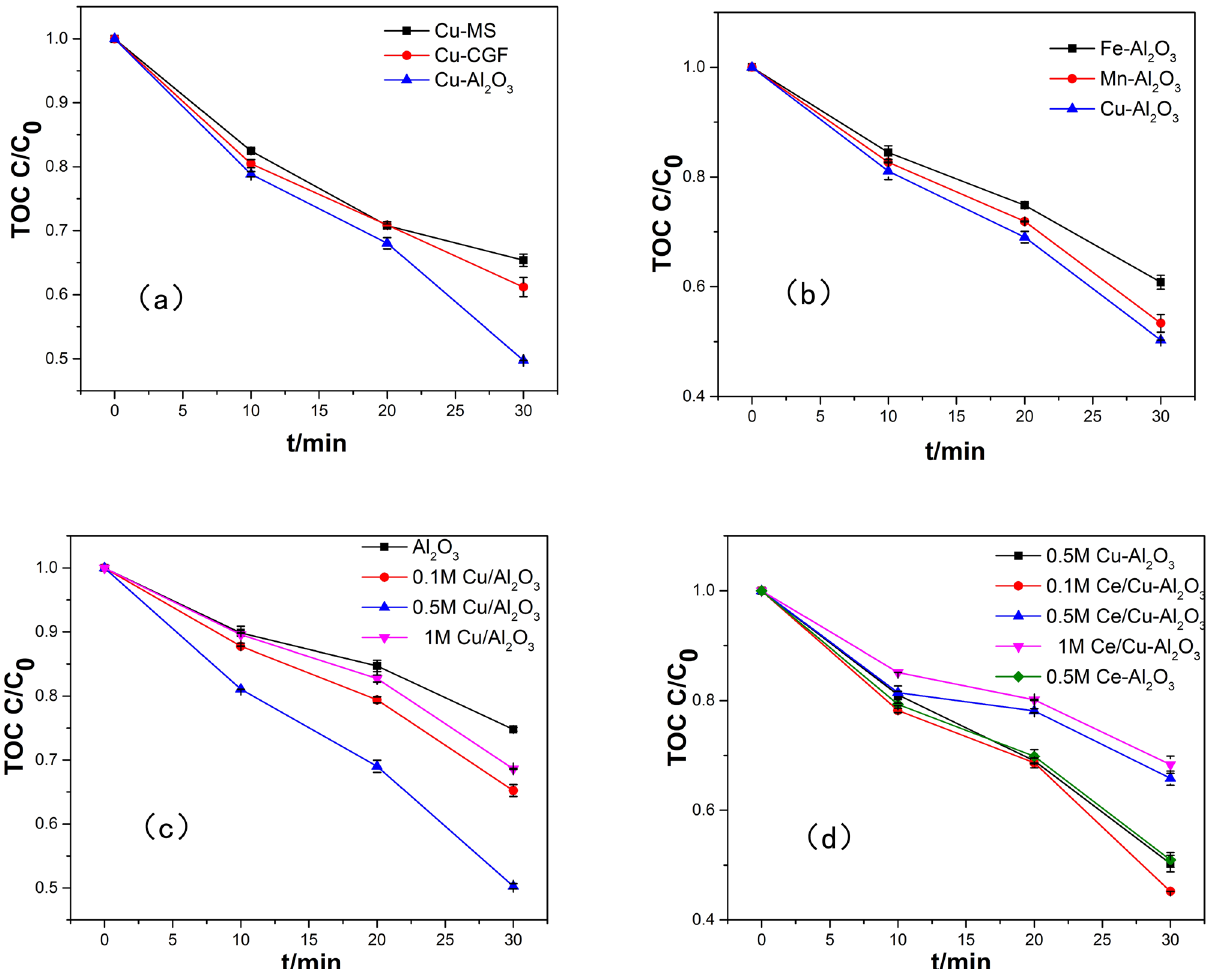
Figure 2. Effects of ( a ) catalyst support materials, ( b ) active components, ( c ) metal content and ( d ) metal compound on catalytic activity (experimental conditions: pH 0 , 6.49; catalyst dosage, 5.0 g/L; gas flow rate, 400 mL/min; ozone concentration, 2.90 mg/L; reaction volume, 1.0 L; and reaction time, 30